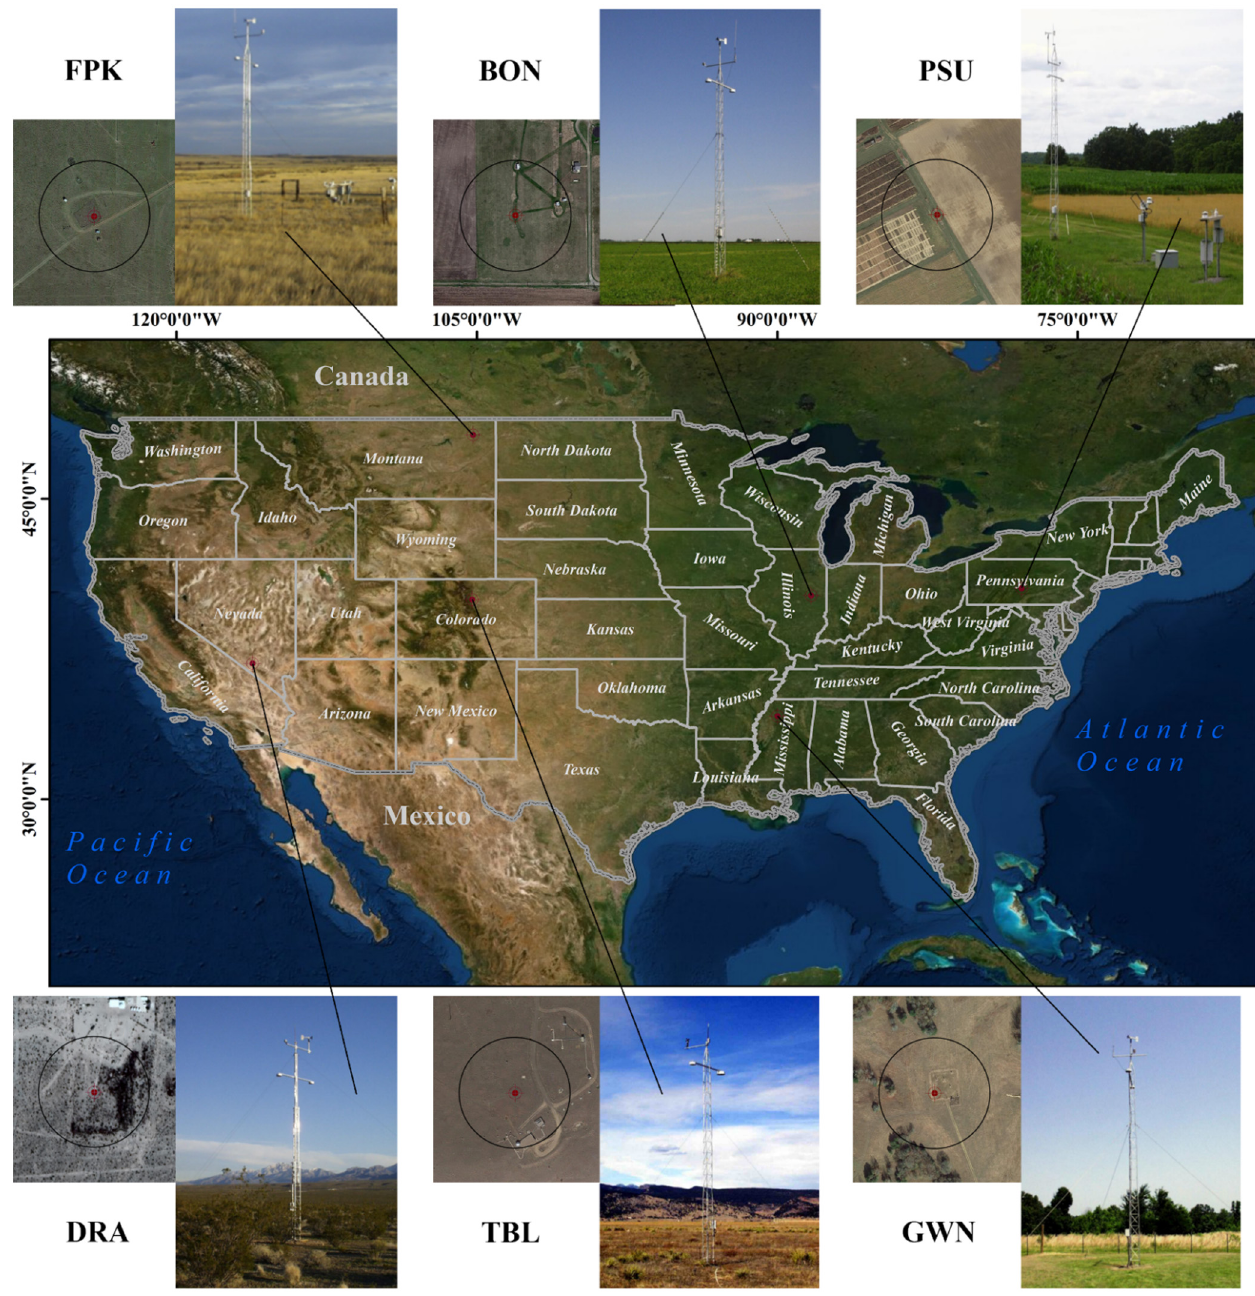
Figure 1. Images of the six ground sites and towers (Table 1) used in this study were acquired from high-resolution satellite data on https://www.google.com/earth. The red markers and black circles represent the location of the measurement towers and the 126-m diameter area they covered, respectively.